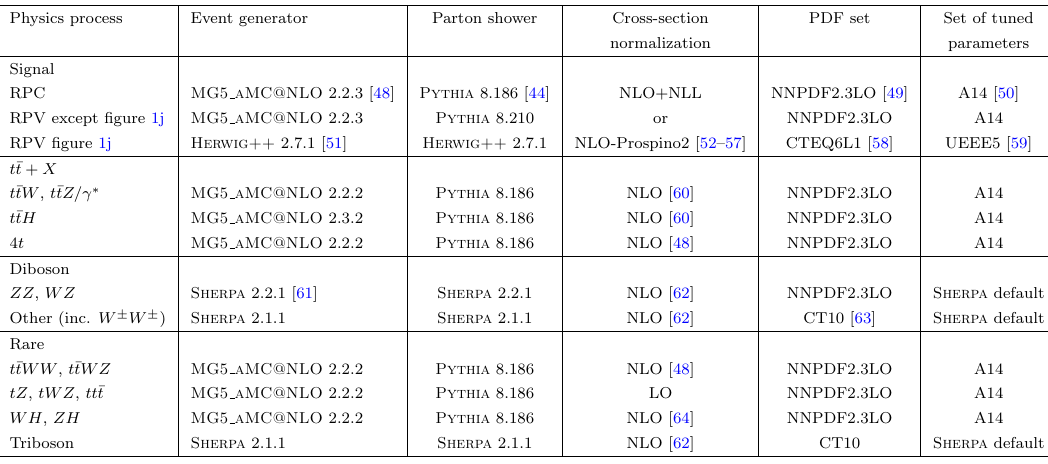
Table 1. Simulated signal and background event samples: the corresponding event generator, parton shower, cross-section normalization, PDF set and set of tuned parameters are shown for each sample. Because of their very small contribution to the signal-region background estimate, t (cid:22) tWW , t (cid:22) tWZ , tZ , tWZ , tt (cid:22) t , WH , ZH and triboson are summed and labelled \rare" in the following. NLO- Prospino2 refers to RPV down squark models of (cid:12)gures 1k and 1l, as well as the NUHM2